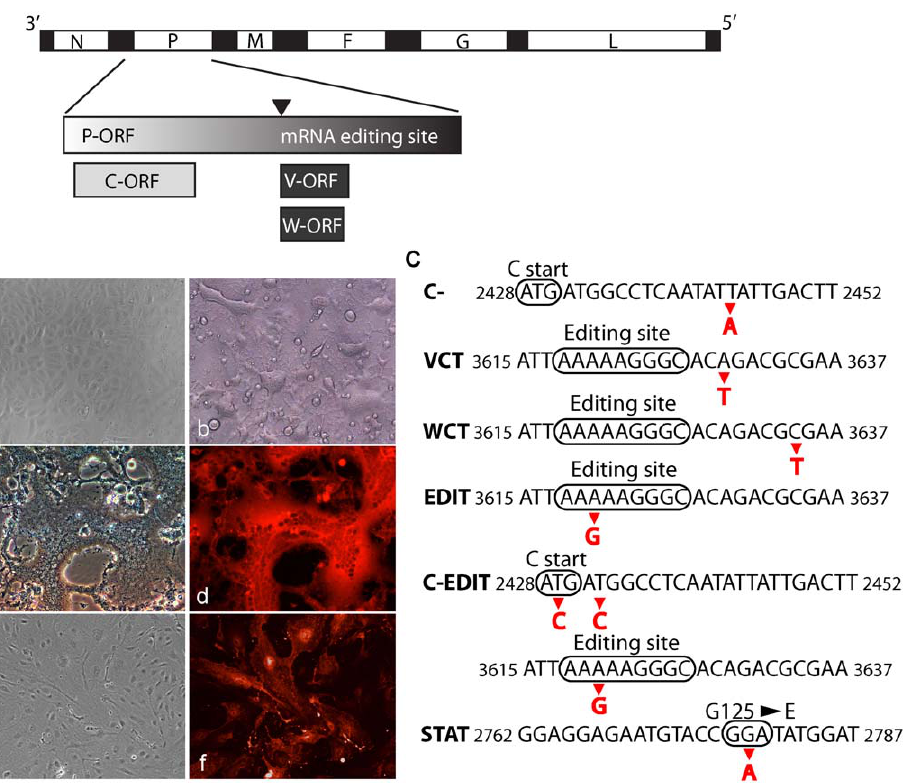
Figure 1. Nipah (NiV) P gene editing, and the establishment of a NiV reverse genetic system. ( A ) Schematic of Nipah (NiV) genome with the name of each gene indicated. Black segments represent non-coding regions of the virus genome, while the white regions indicate open reading frames (ORF). Inset magnifies the P gene and indicates the accessible ORFs in the NiV P gene due to mRNA editing (NiV V and W) and to a downstream alternative ORF (NiV C). Approximate location of the mRNA site is indicated by the black arrowhead. ( B ) Establishment of NiV reverse genetic system. Panel a: mock-infected Vero cells. Panel b: Wild-type recombinant NiV infection of Vero cells at 48 h post infection (PI) (MOI=1). Panels c–d: light and fluorescence micrographs of Vero cells infected with recombinant red fluorescent (RED2AM) virus, 48 h PI (MOI=1). Panels e–f: light and fluorescence micrographs of primary human microvascular lung endothelial cells (HMVEC-L) infected with RED2AM virus, 24 h PI (MOI=2). ( C ) Generation of recombinant NiVs. Nucleotide changes (indicated by red arrowheads and letters) were incorporated into the NiV P gene to ablate expression of the C, V, and W ORFs, to alter the mRNA editing site, or to prevent STAT-1 binding in the shared N-terminal regions of the P, V, and W proteins. Numbers flanking the nucleotide sequences indicate plus-sense antigenomic position.